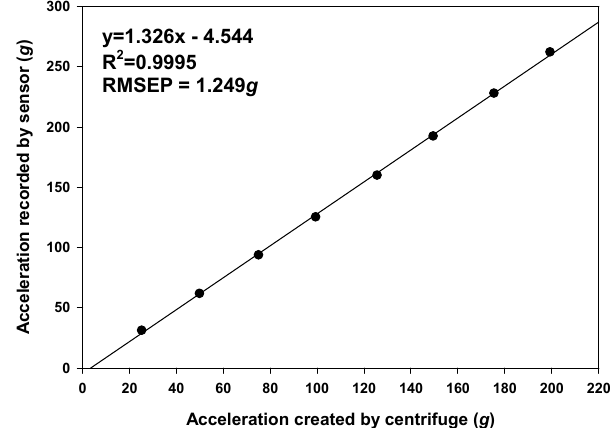
Figure 11. Linear relationship between the acceleration provide by the centrifuge and the values recorded by BIRD II.